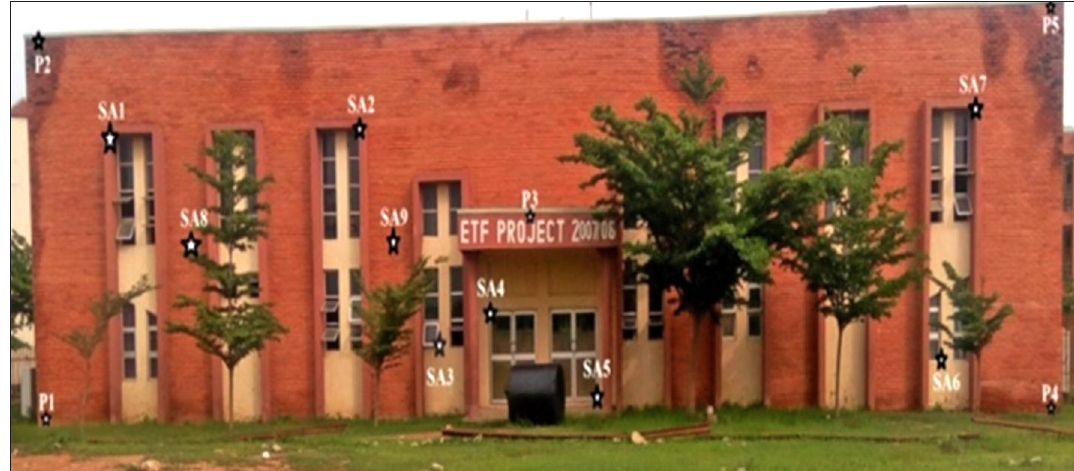
Figure 2. PCPs and check points used for the study